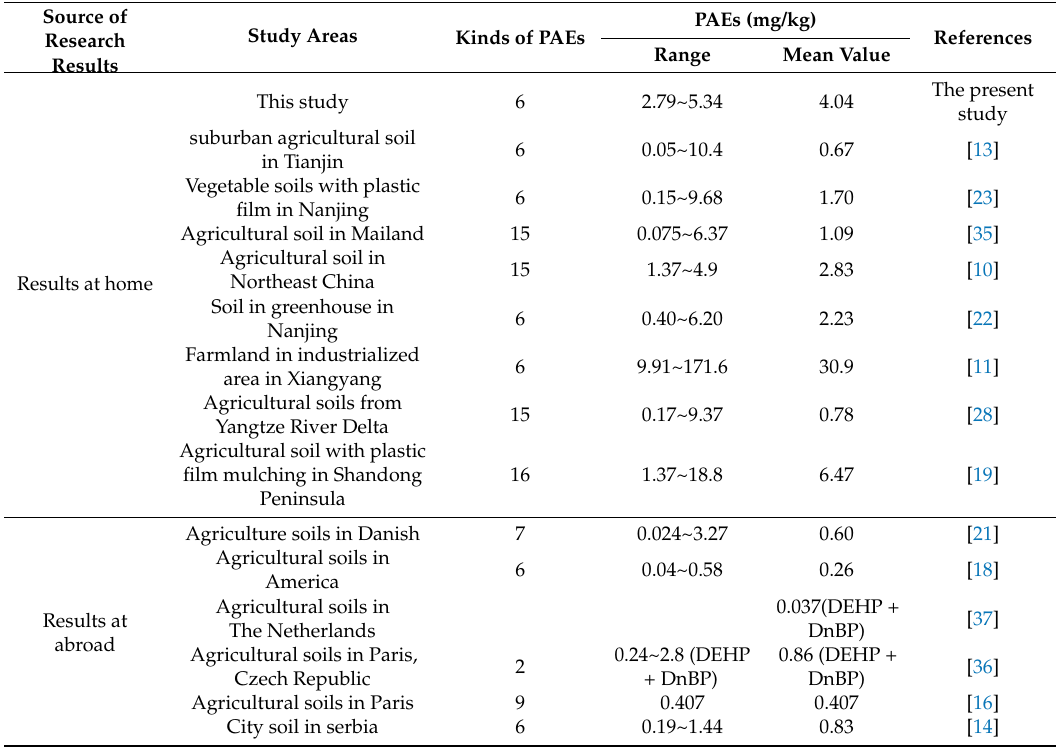
Table 4. The comparison of the concentrations of PAEs in the present study with those of other studies. Source of Research